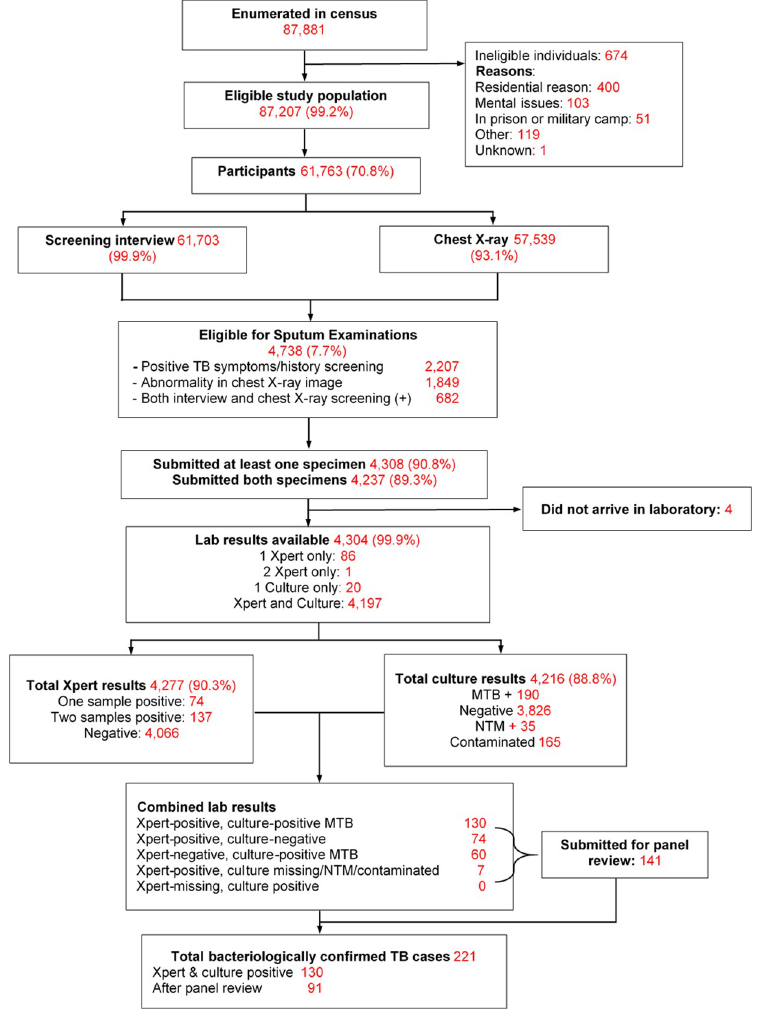
Fig 1. Flow diagram of the 2nd tuberculosis prevalence survey in Vietnam,